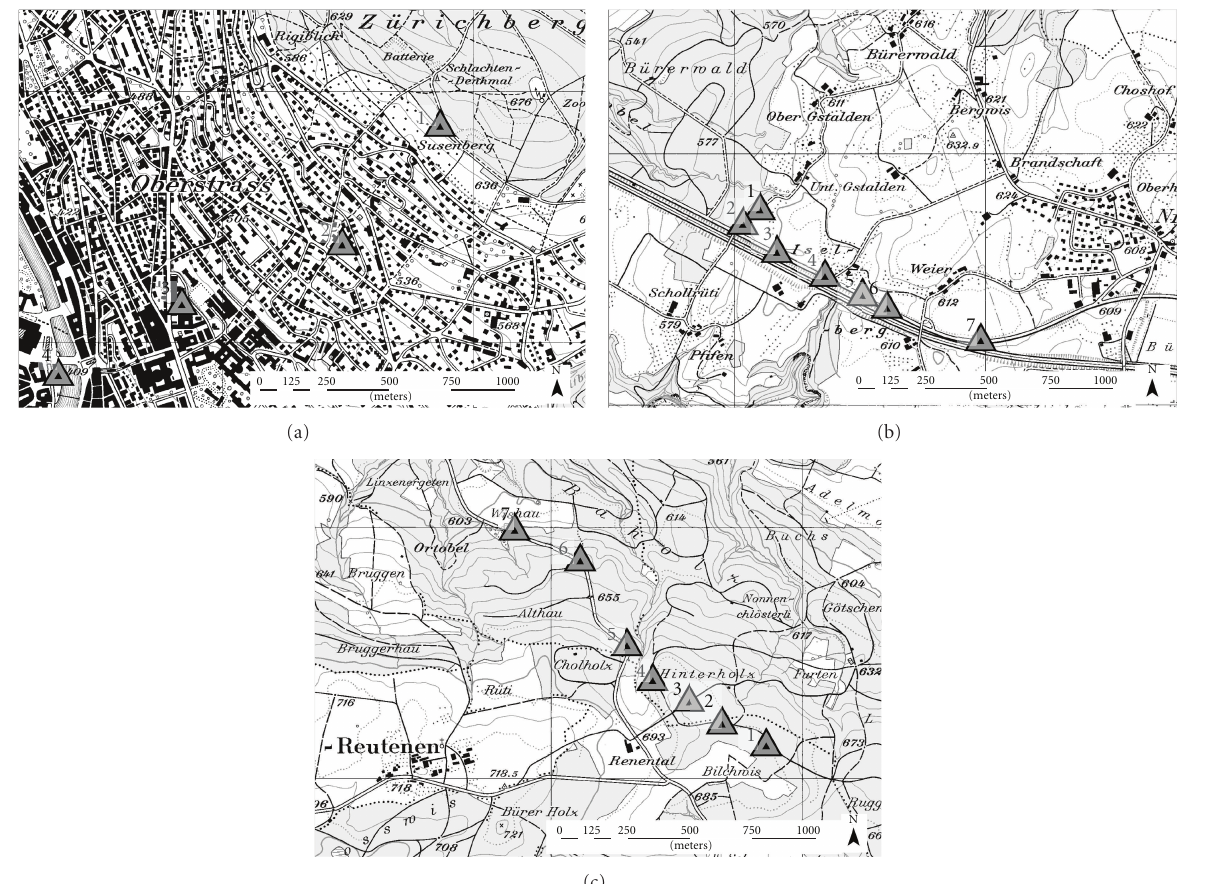
Figure 1: The design of the trap transects in (a) the city, (b) the open land, and (c) the broadleaf stand. All transects start in stands with infestations spots. (Maps: VECTOR 25, swisstopo (JA100118), 2010.) every 14 days, the traps were inspected, emptied, and the beetles